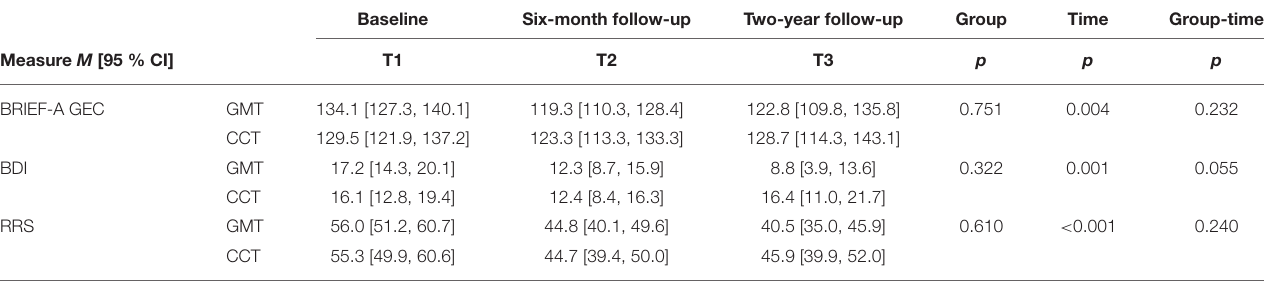
TABLE 3 | Fixed effect estimates from the intention-to-treat linear mixed model sensitivity analysis. Baseline Six-month follow-up Two-year follow-up Group Time